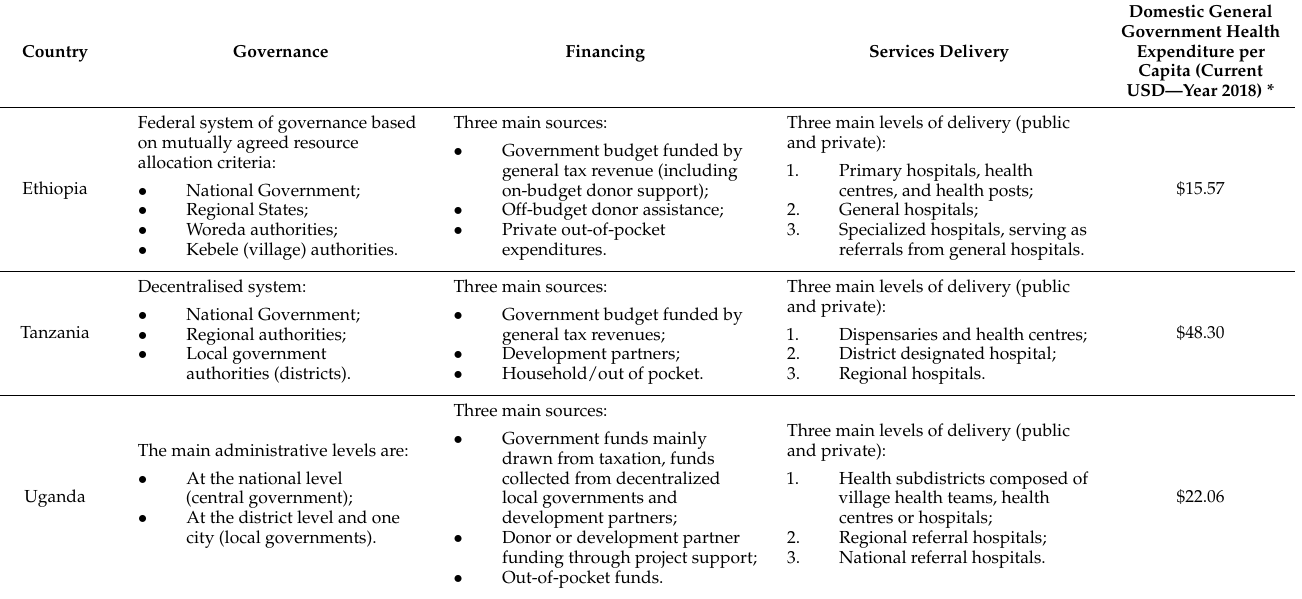
Table 3. Governance models, financing schemes, services delivery levels, and health expenditure per capita from domestic sources by